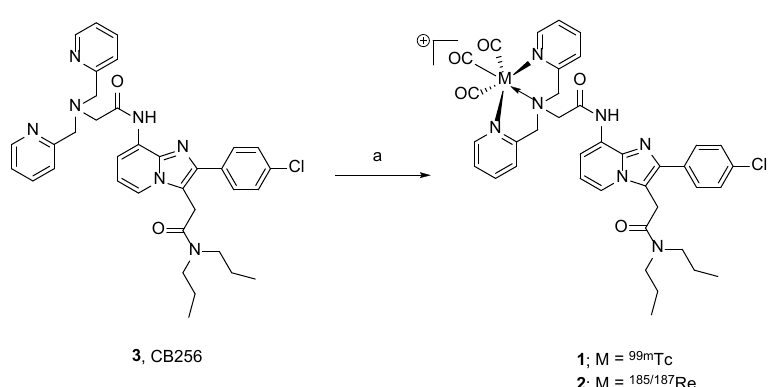
Scheme 1. Synthesis of 99m Tc- and Re-CB256. Reagents and conditions: (a) [ 99m Tc(CO) 3 (H 2 O) 3 ] + ,